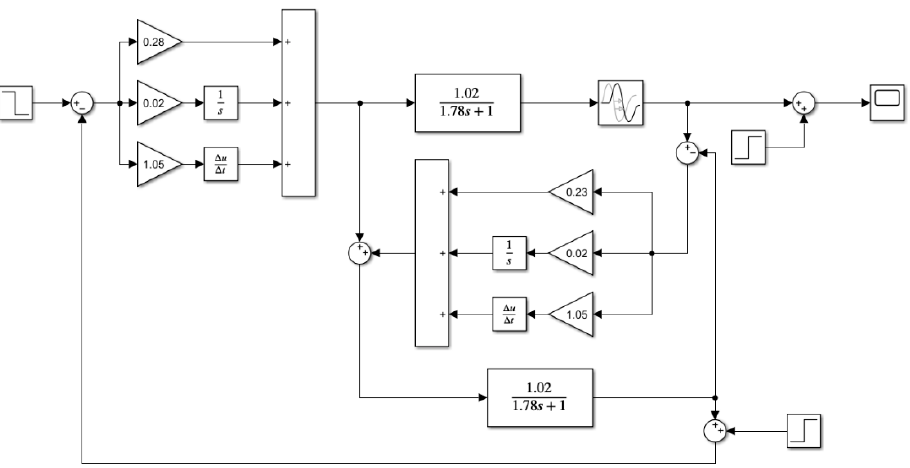
Figure 7. Simulation model of pH regulation system based on PID-Smith prediction compensa- tion.